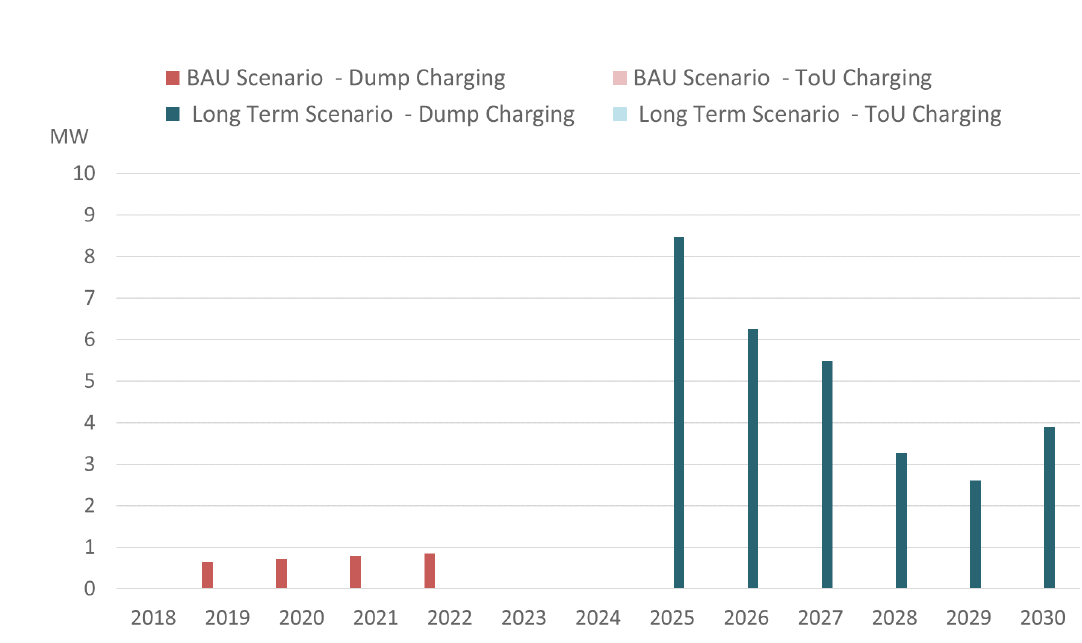
Figure 10: Additional Upward Regulating Reserve requirement of different